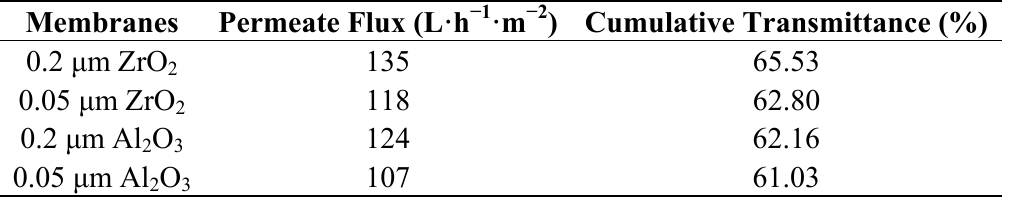
Table 2. Comparison of the performance of different membranes.